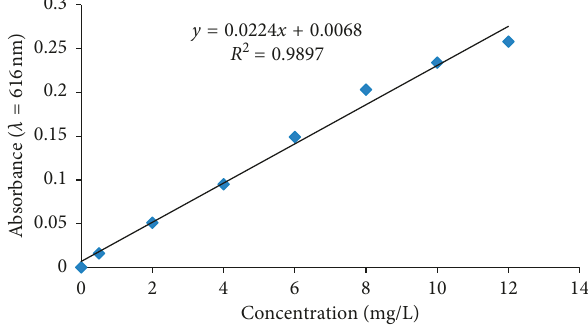
Figure 4: Calibration curve (concentration vs. absorbance) for “Cibacron